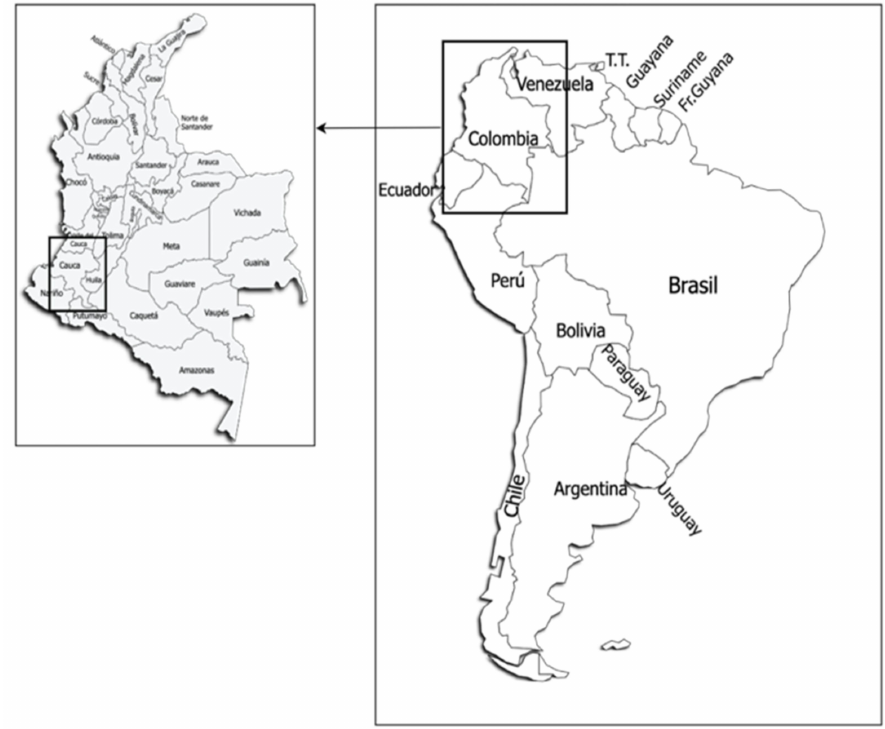
Figure 1. La Sultana Colombian Coffee Farm location (2 ◦ 22 (cid:48) 28.51 (cid:48)(cid:48) N, 76 ◦ 43 (cid:48) 31.89 (cid:48)(cid:48) W). Left map depicts the Colombian Departments and the right map the location of Colombia in South America. Image source [proyectomapamundi].